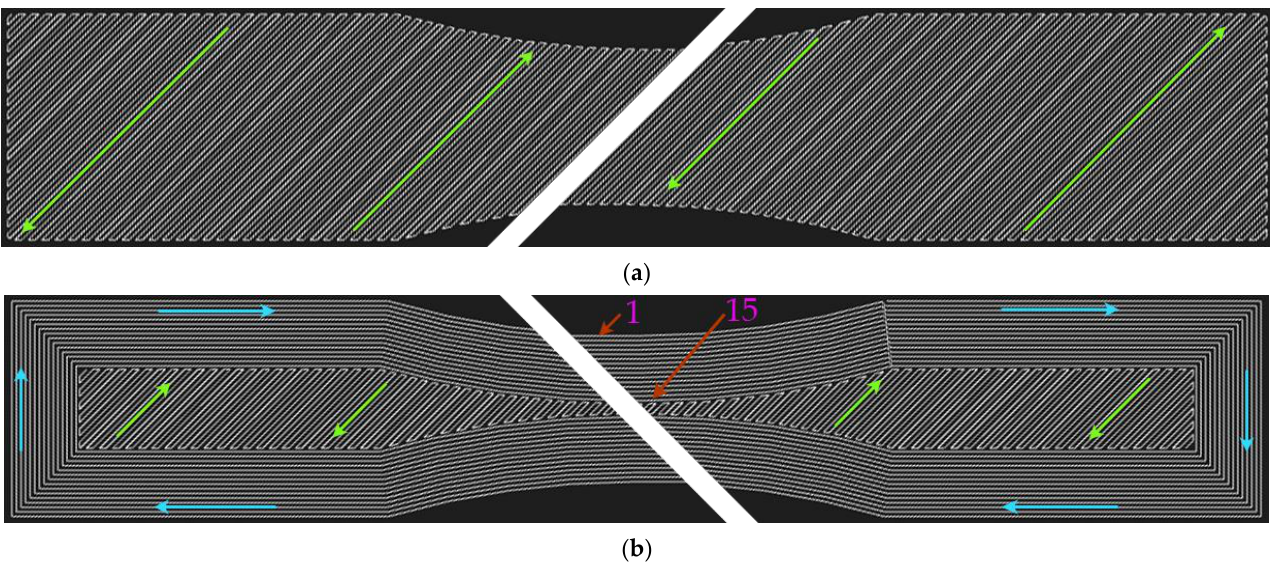
Figure 7. Infill pattern (green arrows) with an orientation of 45 degrees to the loading axis: ( a ) without walls; ( b ) with 15 walls (blue arrows) around the specimen circumference.